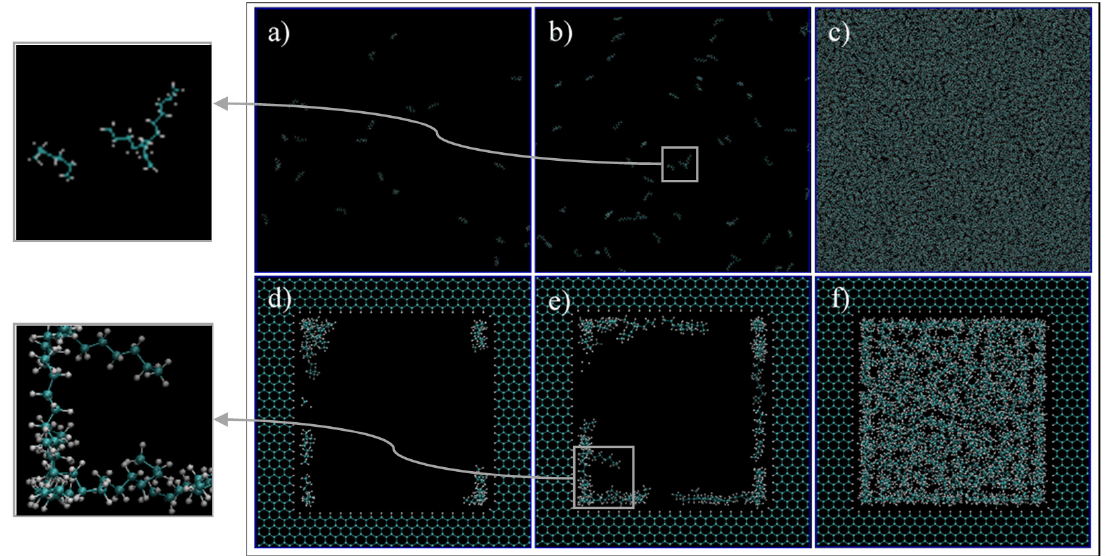
Figure 7. Heptane molecules simulation in bulk ( a – c ) and pore medium ( d – f ) at C1 ( a , d ), C2 ( b , e ), and C3 ( c , f ) condition. C1, C2, and C3 refer to temperature and pressure of 248 °F, 14.7 psia, 248 °F, 54.17 psia, 248 °F, 4000 psia, respectively. Cyan and white spheres are carbon and hydrogen atoms, respectively.